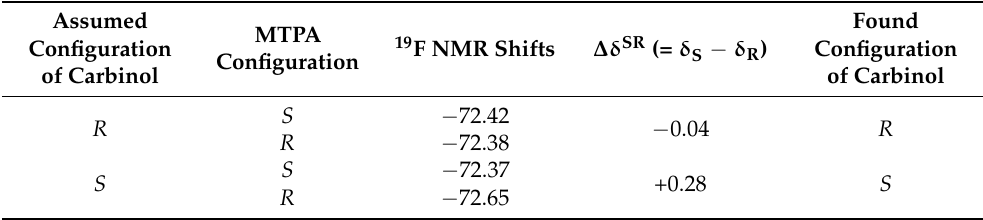
Table 2. Combinations of configurations of 3 ‐ hydrocyeicosapentaenoic acids MTBA ‐ esters ( 15 ) and their chemical shifts.